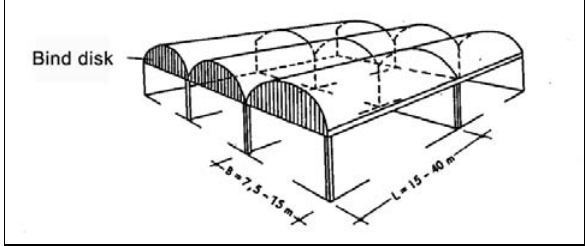
Fig 4. Single-arched shell construction: transverse tons, proportion of the spans